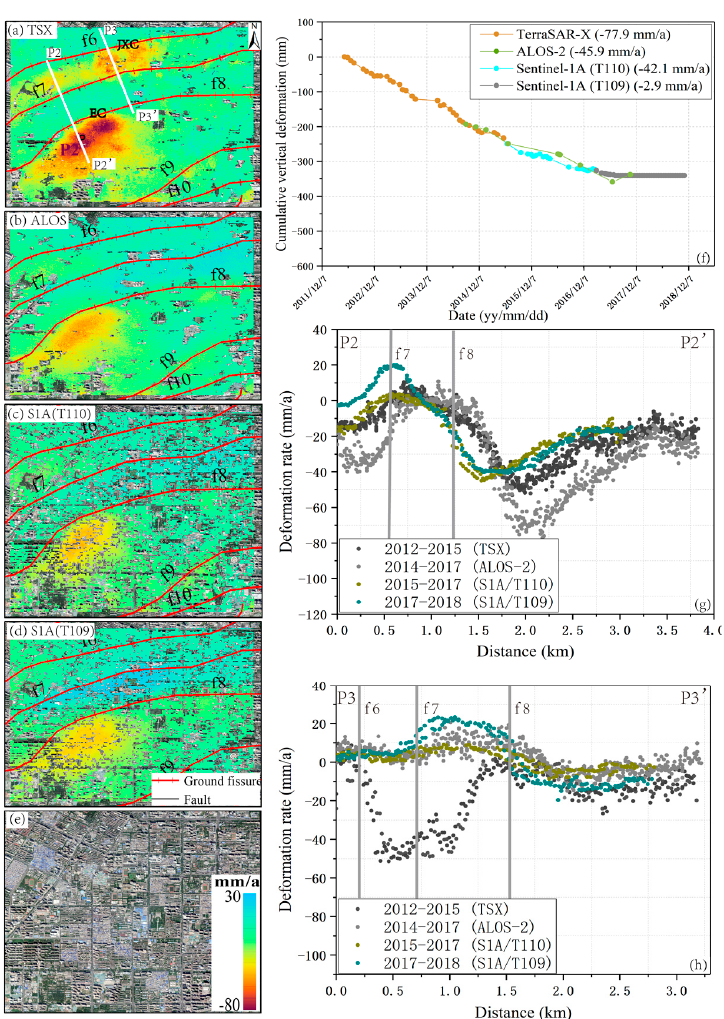
Figure 7. Land subsidence in the EC-JXC area, located in the south-west sector of Xi’an city. ( a ) From 2012 to 2015 with the TerraSAR-X dataset; ( b ) from 2014 to 2017 with the ALOS-2 dataset; ( c ) from 2015 to 2017 with the Sentinel-1A (T110) dataset; ( d ) from 2017 to 2018 with the Sentinel-1A (T109) dataset; ( e ) Google Earth image; ( f ) cumulative time series deformation of P2; ( g ) and ( h ) annual deformation rates from different-band datasets along the profiles P2P2’ and P3P3’ from 2012 to 2018, respectively, whose positions are marked in (a).